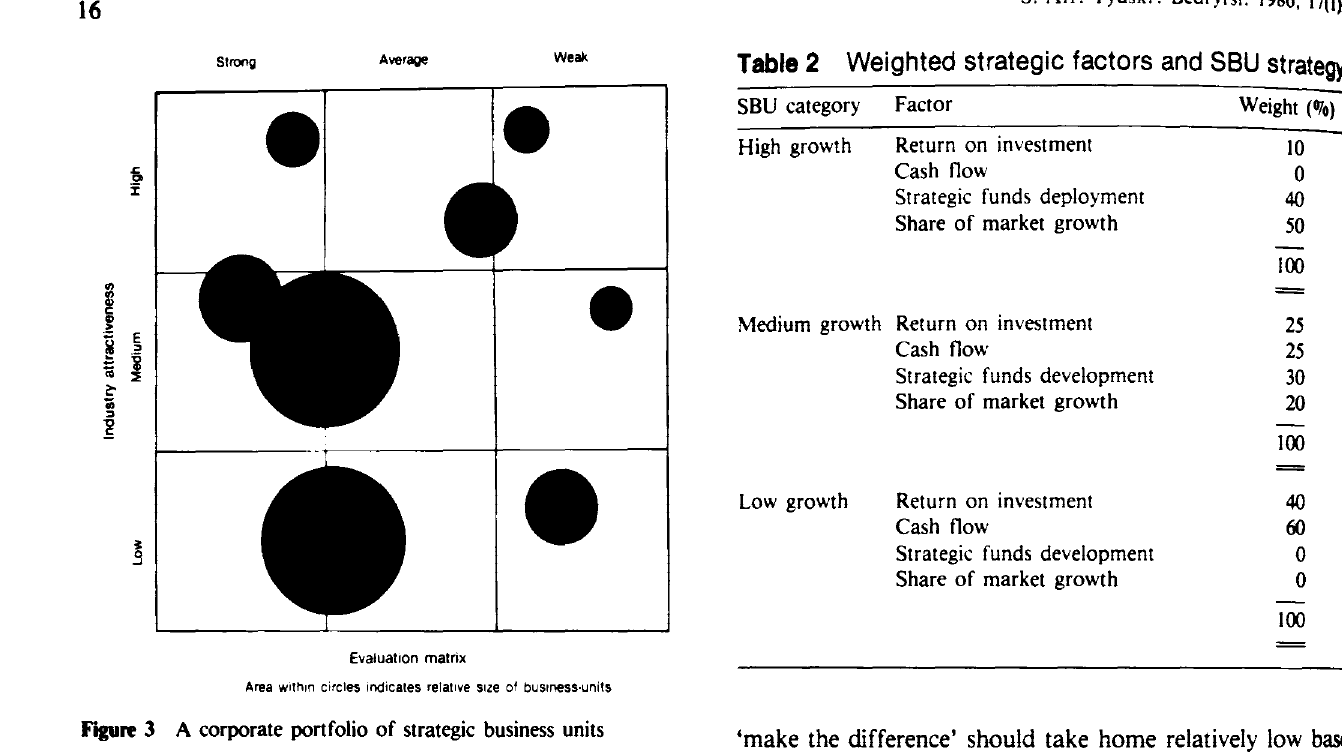
Figure 3 A corporate portfolio of strategic business units a compensation plan that recognizes the different factors that are required of a particular strategy. Table 2 illustrates one possible plan which weights the relative importance of the factors.